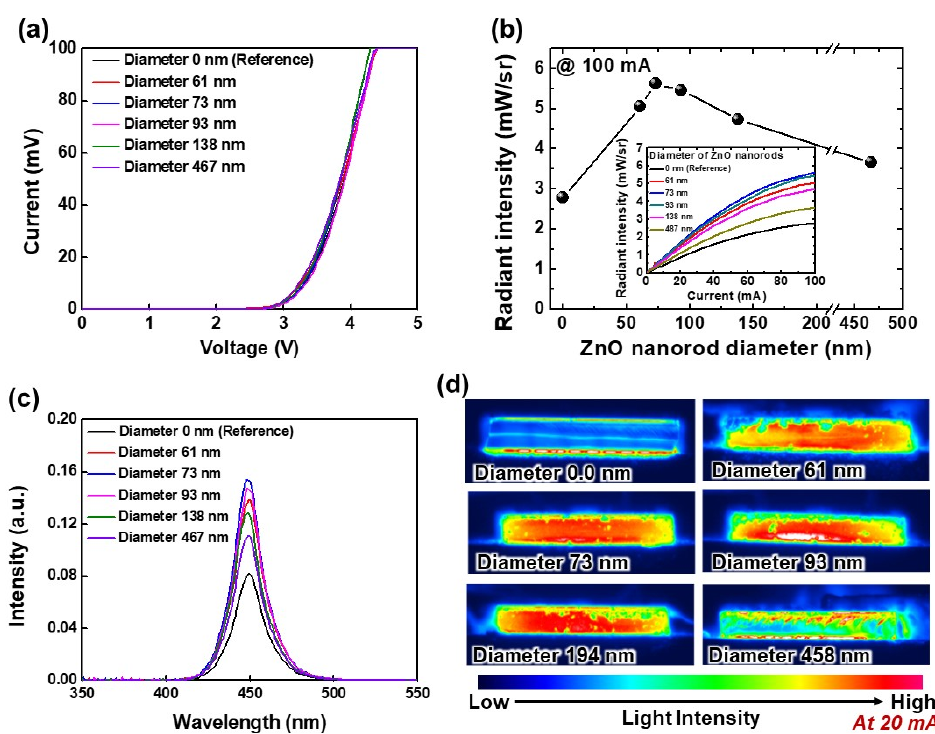
Figure 6. ( a ) I-V characteristics of reference and various diameters nanorod-base USE-LEDs. ( b ) Change in LOP with the variation of ZnO nanorod diameters at 100 mA. Inset shows the current vs. LOP characteristics of USE-LED devices. ( c ) EL spectra, and ( d ) EL intensity distribution over the sidewall area at 20 mA for without and with various diameters nanorod-based USE-LEDs.